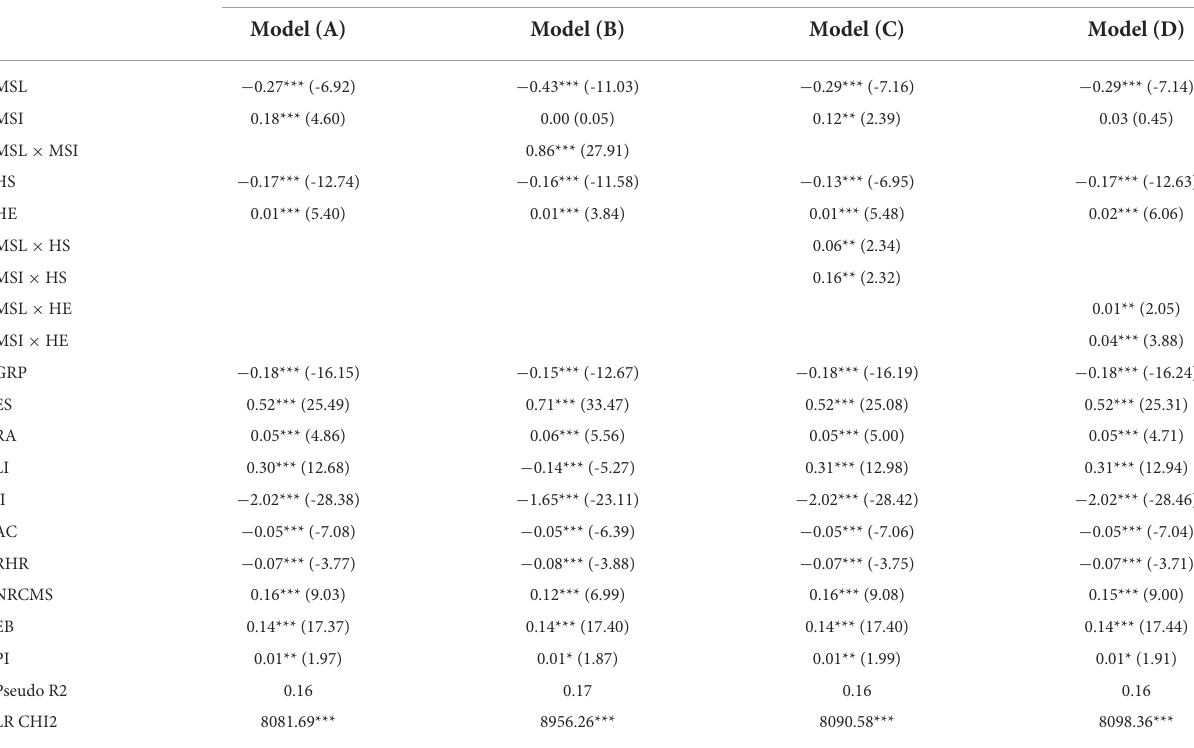
TABLE 3 Results of Probit